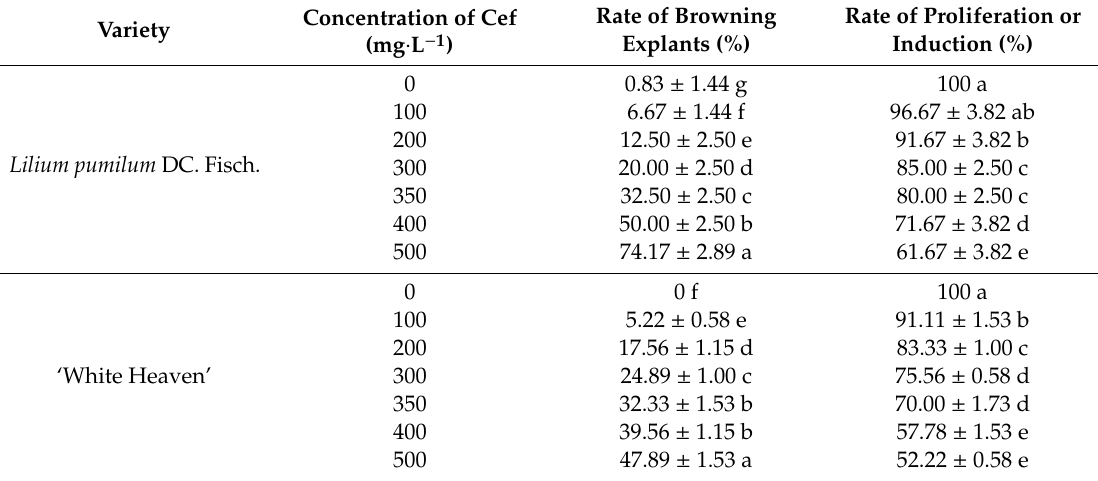
Rate of Proliferation or Induction (%)